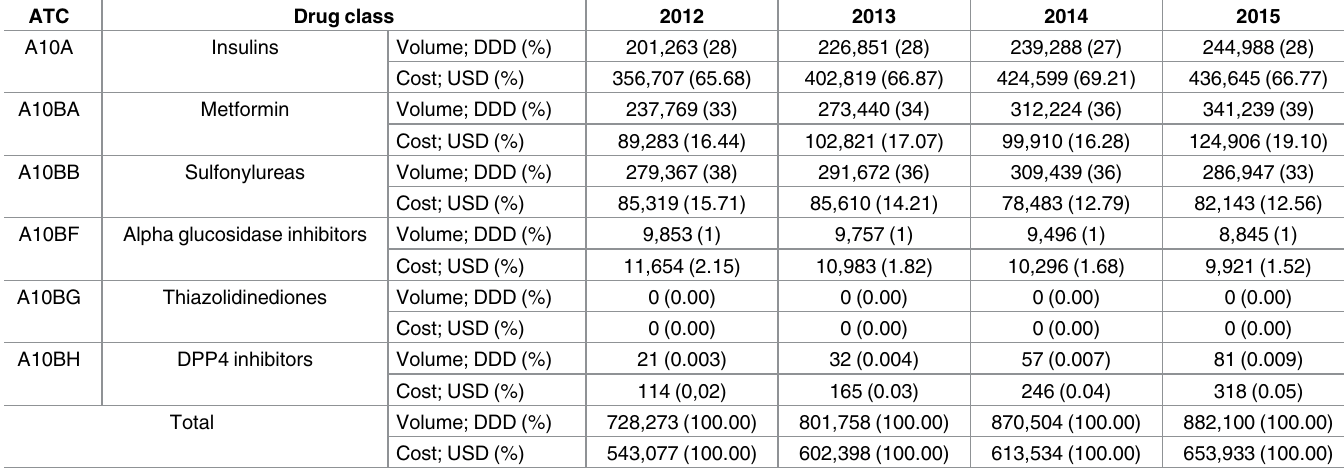
Table 1. Volume and cost of antidiabetic medications in Poland. Number of DDDs in the thousands. Costs in USD x